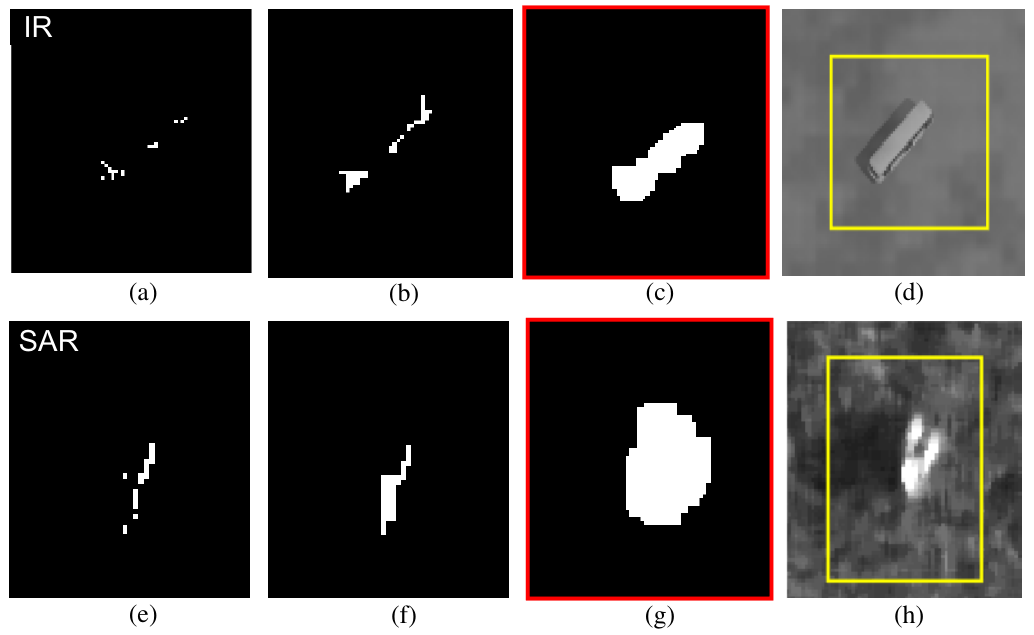
Figure 11. Asymmetric morphological closing filter (AMCF)-based IR/SAR target detection results: ( a ) initial IR target detection in BMVT; ( b ) conventional symmetric morphological closing filter (IR, k = 18, l = 18); ( c ) proposed asymmetric morphological closing filter (IR, k = 18, l = 10); ( d ) detected IR target; ( e ) initial SAR target detection in BMVT; ( f ) conventional symmetric morphological closing filter (SAR, k = 18, l = 18); ( g ) proposed asymmetric morphological closing filter (SAR, k = 18, l = 10; ( h ) detected SAR